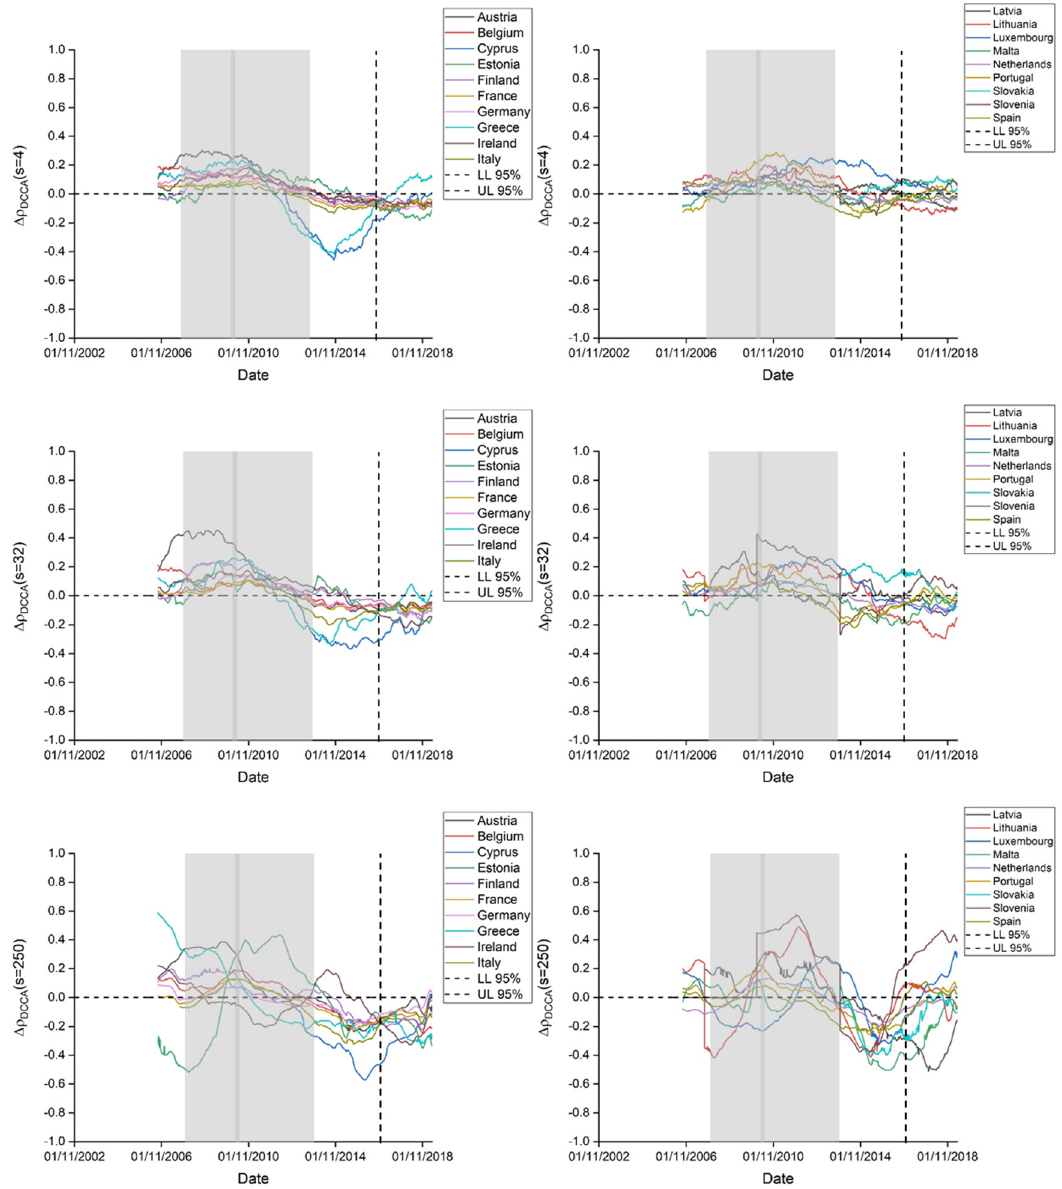
Figure 6. Evolution of the ∆ ρ DCCA between Eurozone stock markets and the UK for time scales of 4, 32, and 250 days, considering that ∆ ρ DCCA ( 1 ) = ρ DCCA ( 1001 ) − ρ DCCA ( 1 ) . LL and UL are, respectively, the lower and upper limits of the confidence interval. Shaded areas represent the global financial crisis and the Eurozone debt crisis. The vertical dashed line refers to the moment of the Brexit referendum.